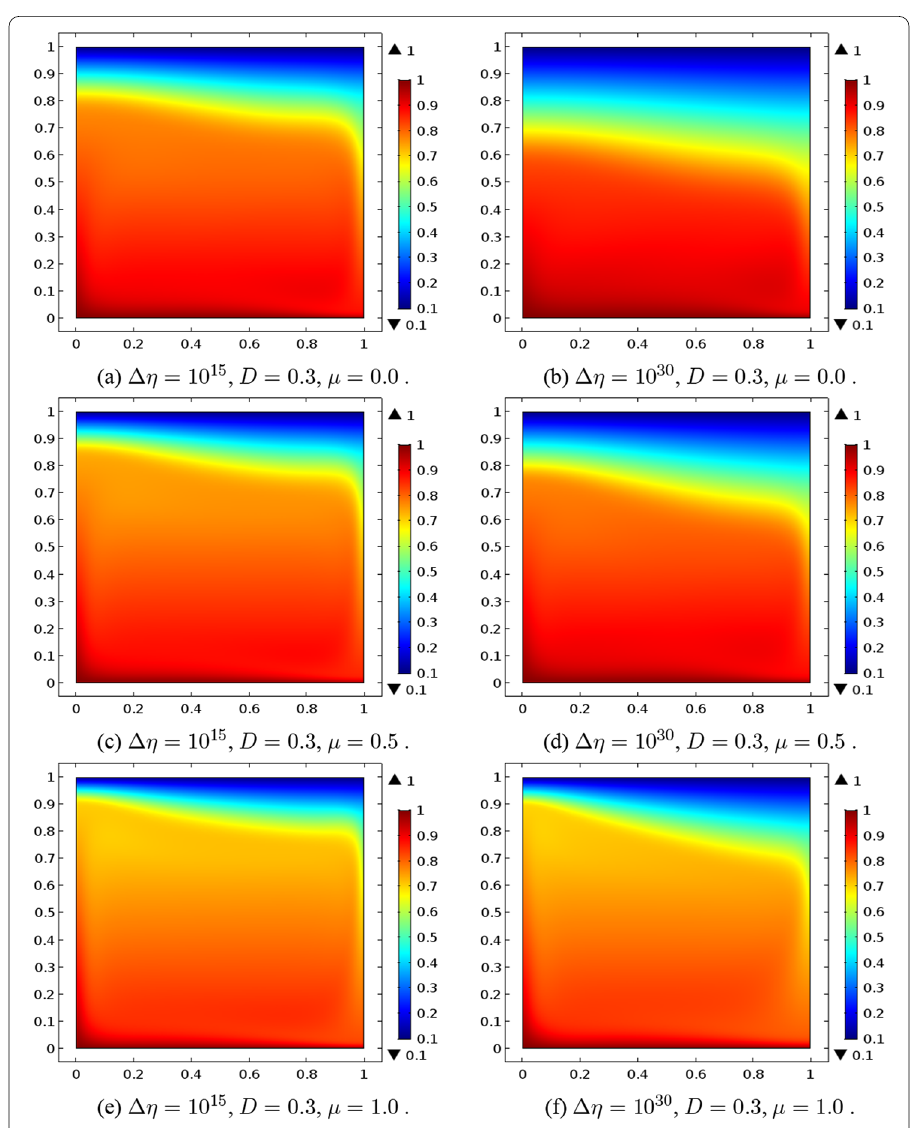
Fig. 2 Thermal distributions of a convection at different viscosity variations and at different pressure numbers for a fixed viscous dissipation number D = 0.3 with θ 0 = 0.1 and Ra = 10